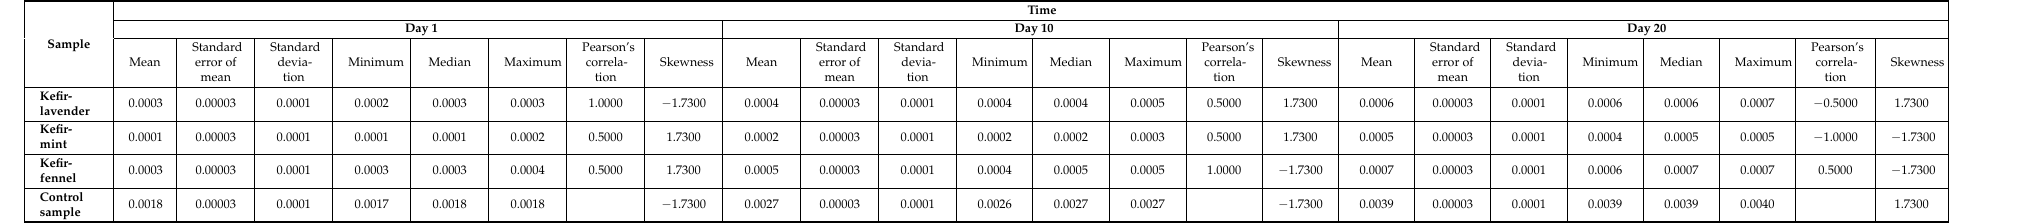
Table A5. Determination of acetic acid content.